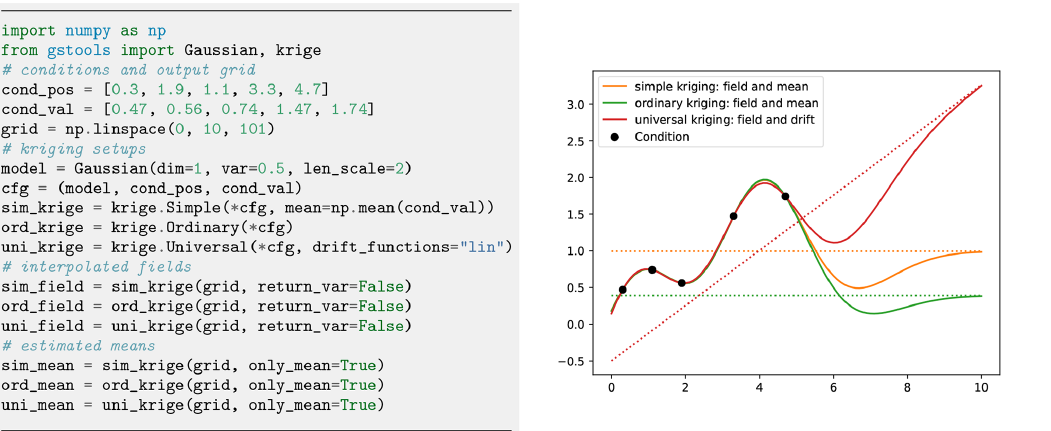
Figure 9. Comparison of simple, ordinary and universal kriging. All three routines have a similar setup, where simple kriging needs an estimated mean and where universal kriging needs additional drift functions. Plotting commands have been omitted.